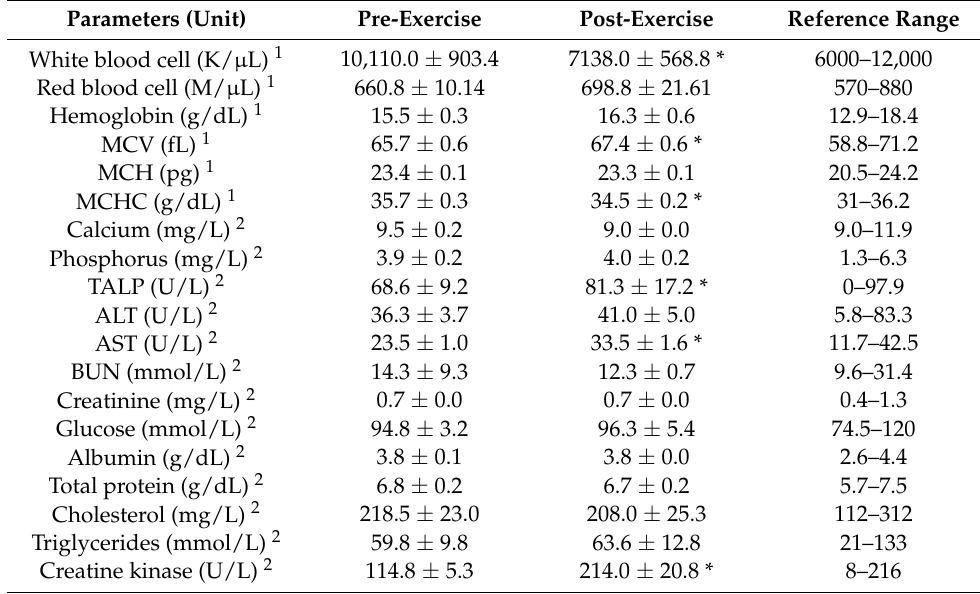
Table 3. Analysis of hematological and serum biochemistry in